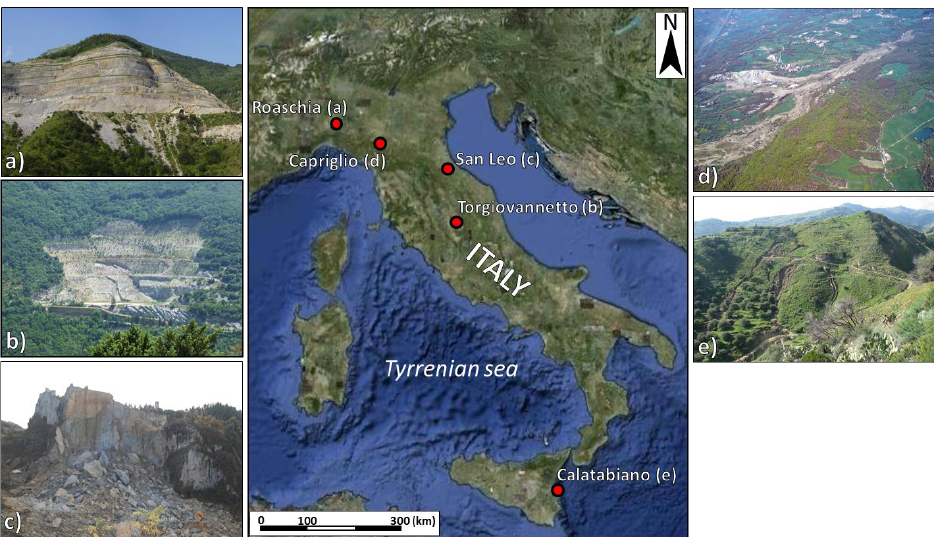
Figure 5. Location of the experimental sites: potential rock slide in active limestone quarry ( a ); active rock slide in an abandoned limestone quarry ( b ); rock fall-affected sub-vertical organogenic-calcarenitic cliff in cultural heritage site ( c ); large fast moving earth flow threatening villages and roadways ( d ); a composite earth slump-flow which damaged a water pipe transect of the Messina city acqueduct ( e ).